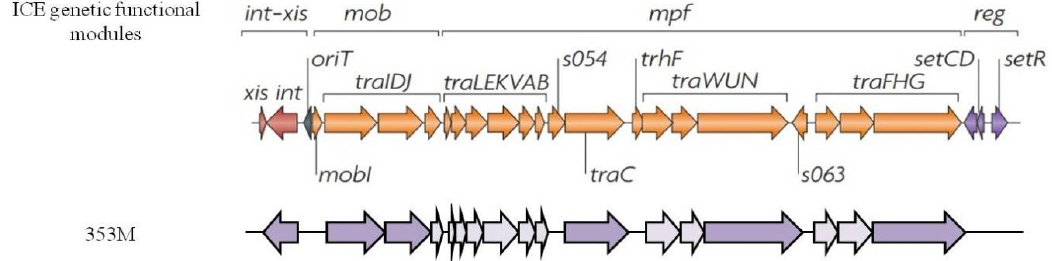
Figure 2. Description of the integrative and conjugative element (ICE) detected in the isolate 353M. At the top of the picture the genetic functional modules present in ICEs are reported [58]; at the bottom the encoding genes found in the strain 353M (dark violet) belonging to xis / int , mob and mpf modules and the other conjugal proteins (light violet) predicted as hypothetical but containing protein domains involved in conjugation and transfer at BLAST analysis are shown.